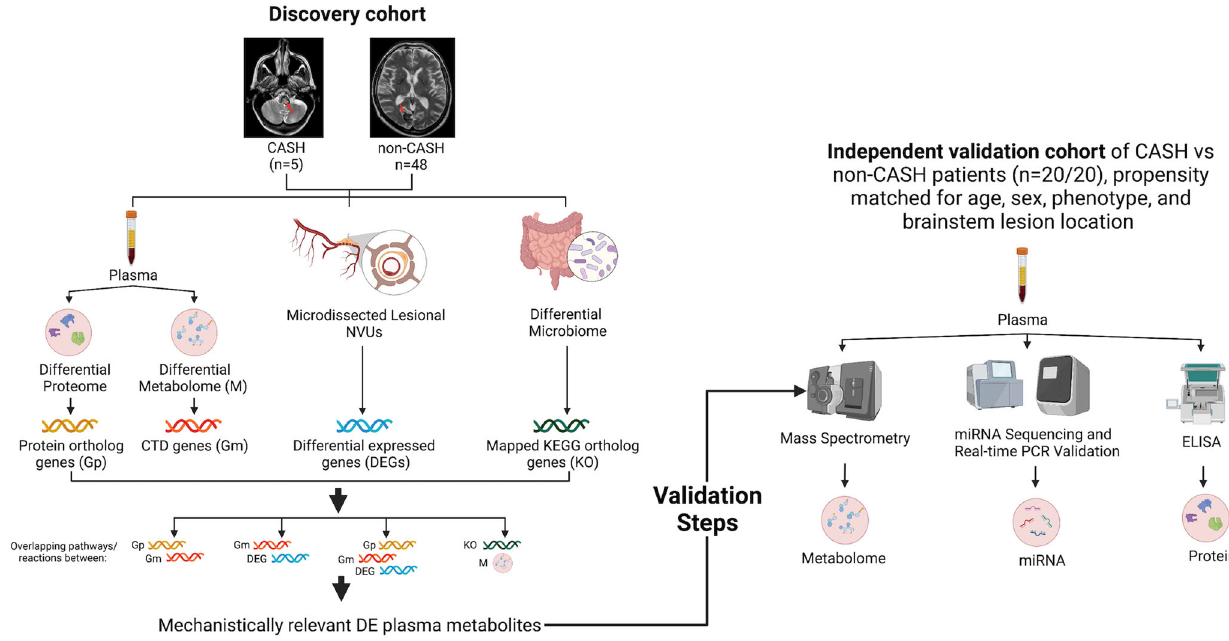
Fig. 1 Methodology for analytic multi-omics integration of differential plasma metabolome and proteome, microbiome and lesional transcriptome, in cavernous angioma (CA) disease. A pipeline was implemented to study the integration of multiomic datasets of CA disease. The interacting Comparative Toxicogenomics Database (CTD) genes and their associated Kyoto Encyclopedia of Genes and Genomes (KEGG) pathways of the differential plasma metabolite ( p < 0.05, FDR corrected; Bayes factor>3) were fi rst identi fi ed and then analytically compared to the enriched-KEGG pathways of the differential plasma proteome, and lesional transcriptome ( p < 0.05, FDR corrected; Bayes factor>3). The differential metabolites were then validated in an independent cohort, propensity matched for age, sex, brainstem lesion, and genotype. NVUs neurovascular